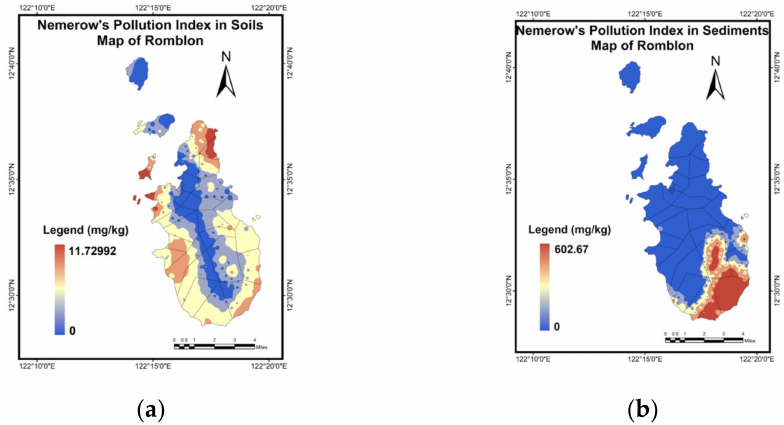
Figure 6. NN-PSO-IDW map for ( a ) Soils; ( b ) Sediments. The NN-PSO simulation results are presented in Tables 4 and 5 for soils and sediments, respectively. This includes the structure of the models. The training algorithm used